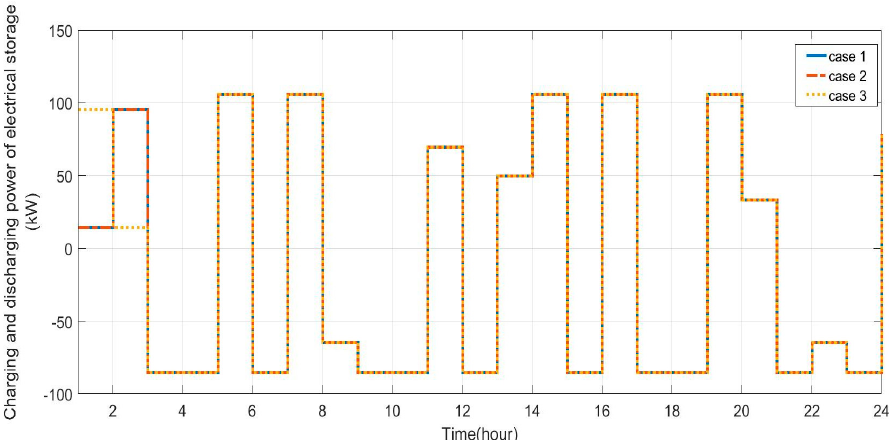
Figure 5. Charging and discharging power of the electrical storage in scenario